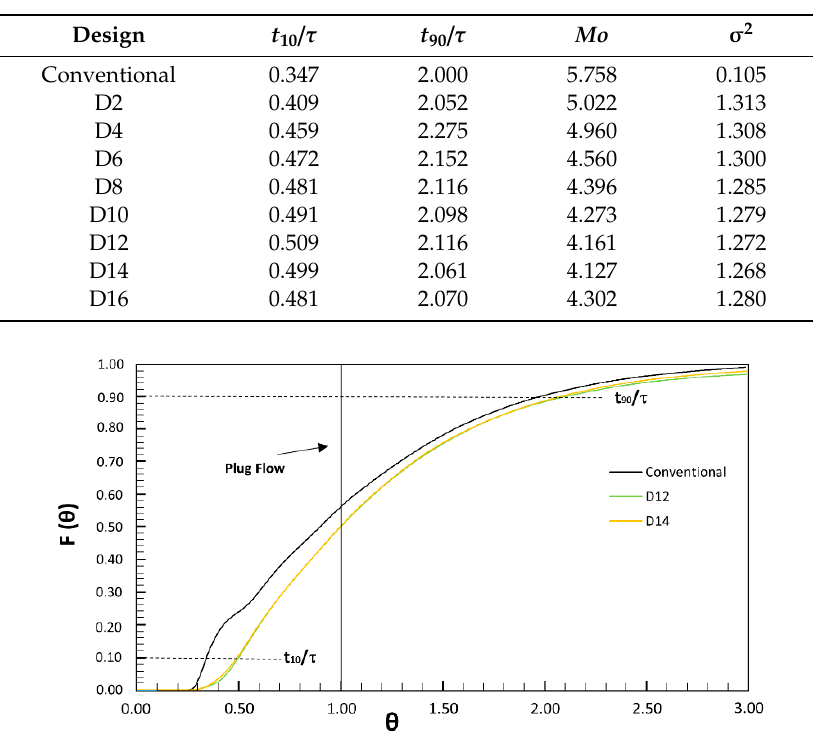
Figure 6. Comparison of cumulative RTD (CRTD) curves of conventional, D12 and D14 designs.